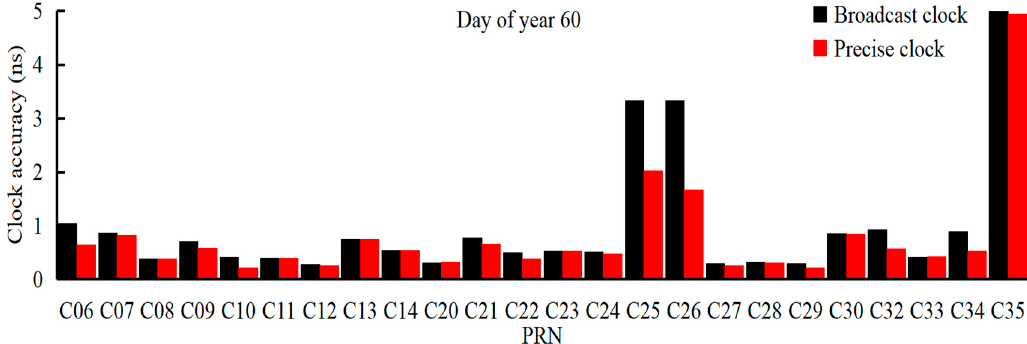
Figure 13. The daily accuracy of the ultra-rapid observed orbit of each satellite obtained from the broadcast and predicted clocks on DOY 60.